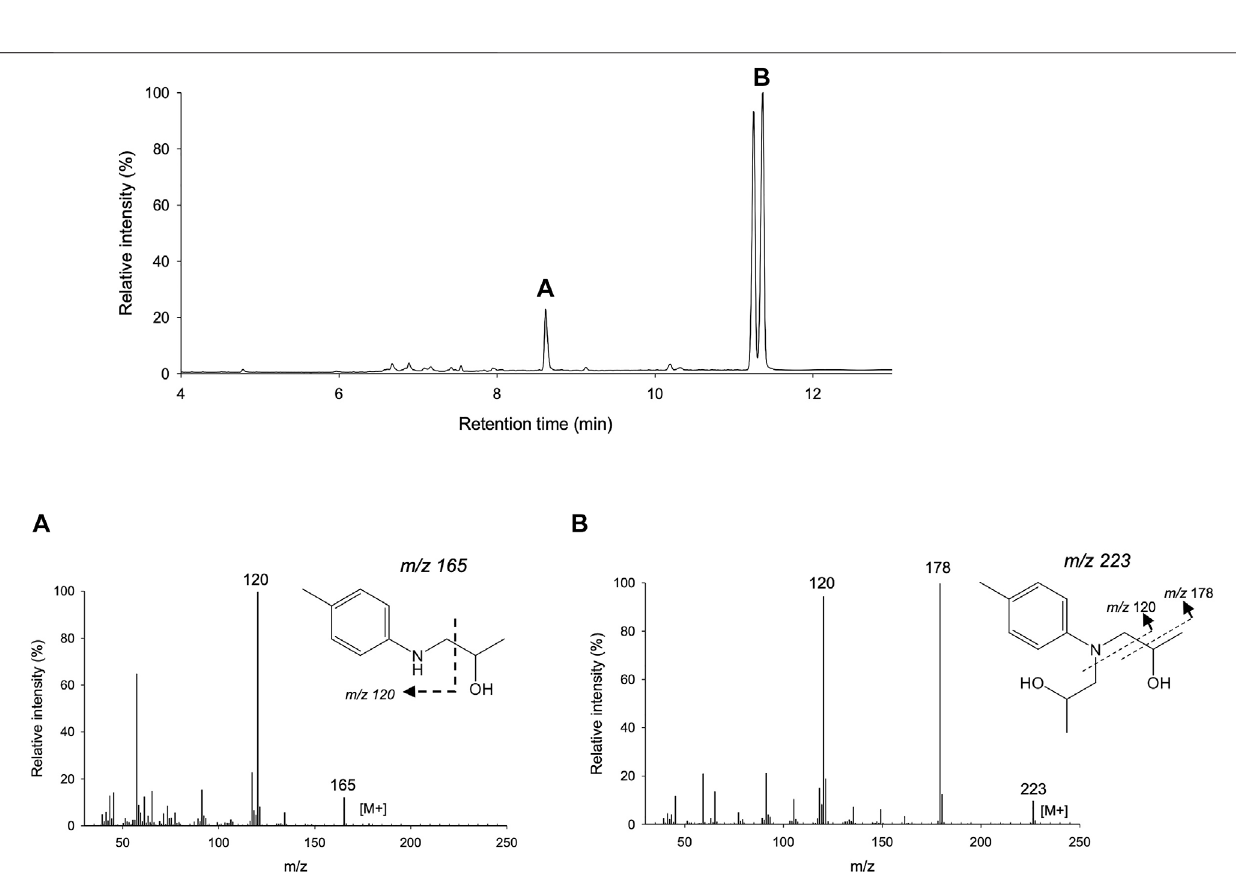
Frontiers in Catalysis |